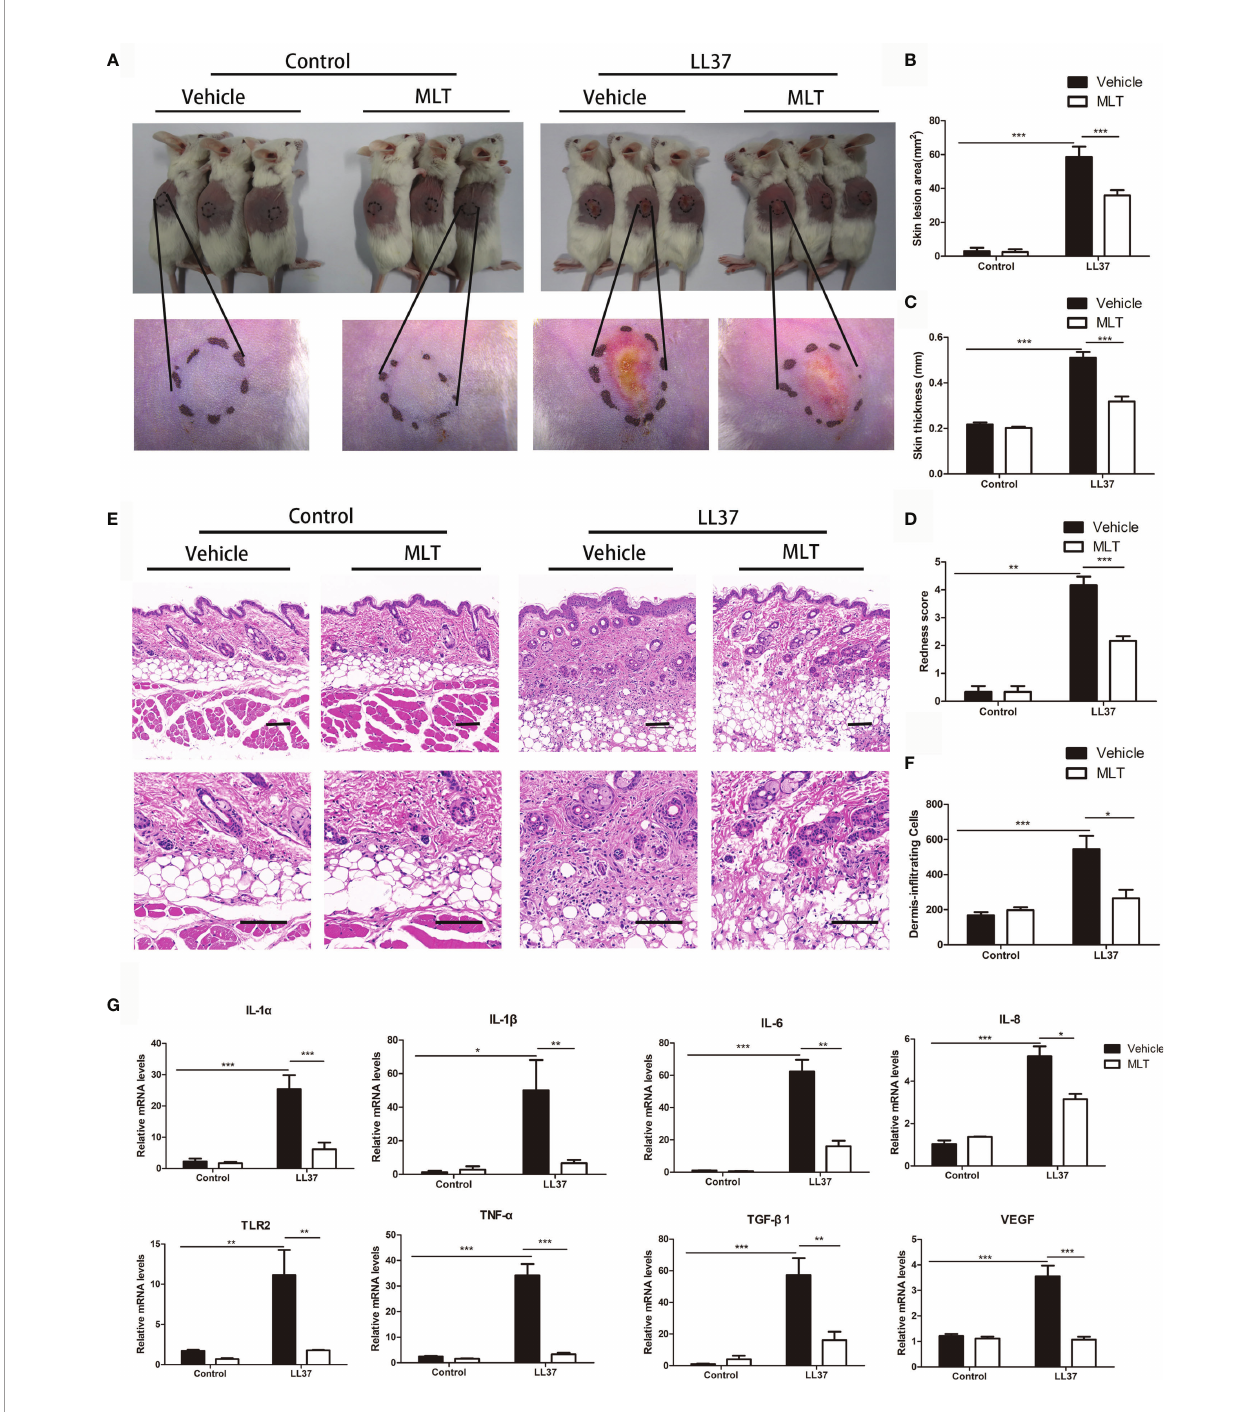
FIGURE 5 | The treatment effects of MLT on rosacea. (A) MLT signi fi cantly alleviated rosacea-like phenotype in mice. The effects of MLT on lesion area (B) , skin thickness (C) , and redness score (D) in rosacea-like mice. (E) H&E staining of rosacea-like lesion. Scale bars: 100 m m. (F) Dermal in fl ammatory cell in fi ltration was quanti fi ed in rosacea-like mice. (G) The mRNA expression of rosacea-related markers in mice. All results are representative of at least three independent experiments. Data expressed as individual values with mean ± SEM. * P < 0.05, ** P < 0.01, *** P <